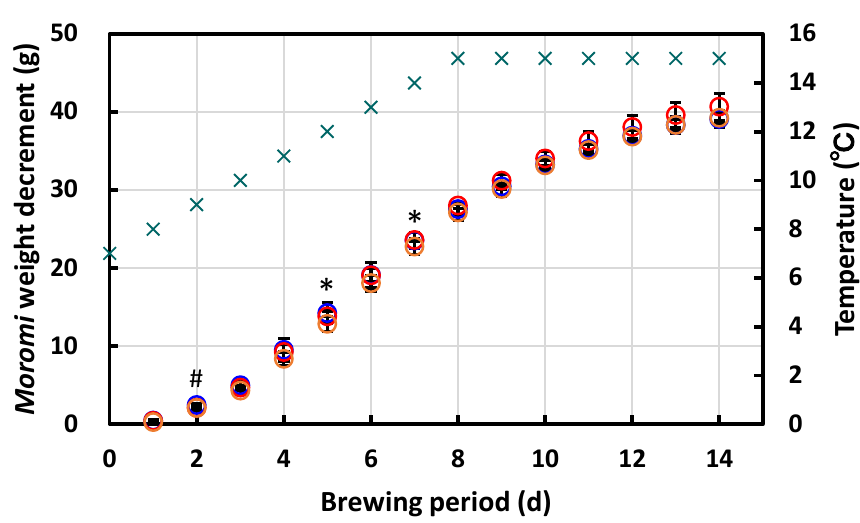
Figure 8. The moromi weight decrement during 14 d in a laboratory-scale sake brewing test using strains S9arg (blue circles), UV1 (red circles), and NM1 (orange circles). Temperature is also shown in green crosses. Values are presented as mean ± standard deviation from three independent experiments. Significant difference ( p < 0.05) between UV1 and S9arg (asterisks) and between NM1 and S9arg (number sign) are indicated. Table 3. Concentration of ethanol and flavor components in the moromi after the laboratory-scale brewing